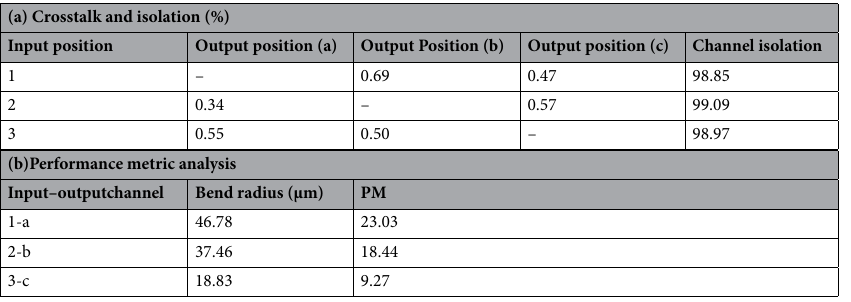
Table 2. Experimental results. a Crosstalk measurement data for various positions of the input and output fibers with resultant channel isolation. b PM analysis for each input–output channel.